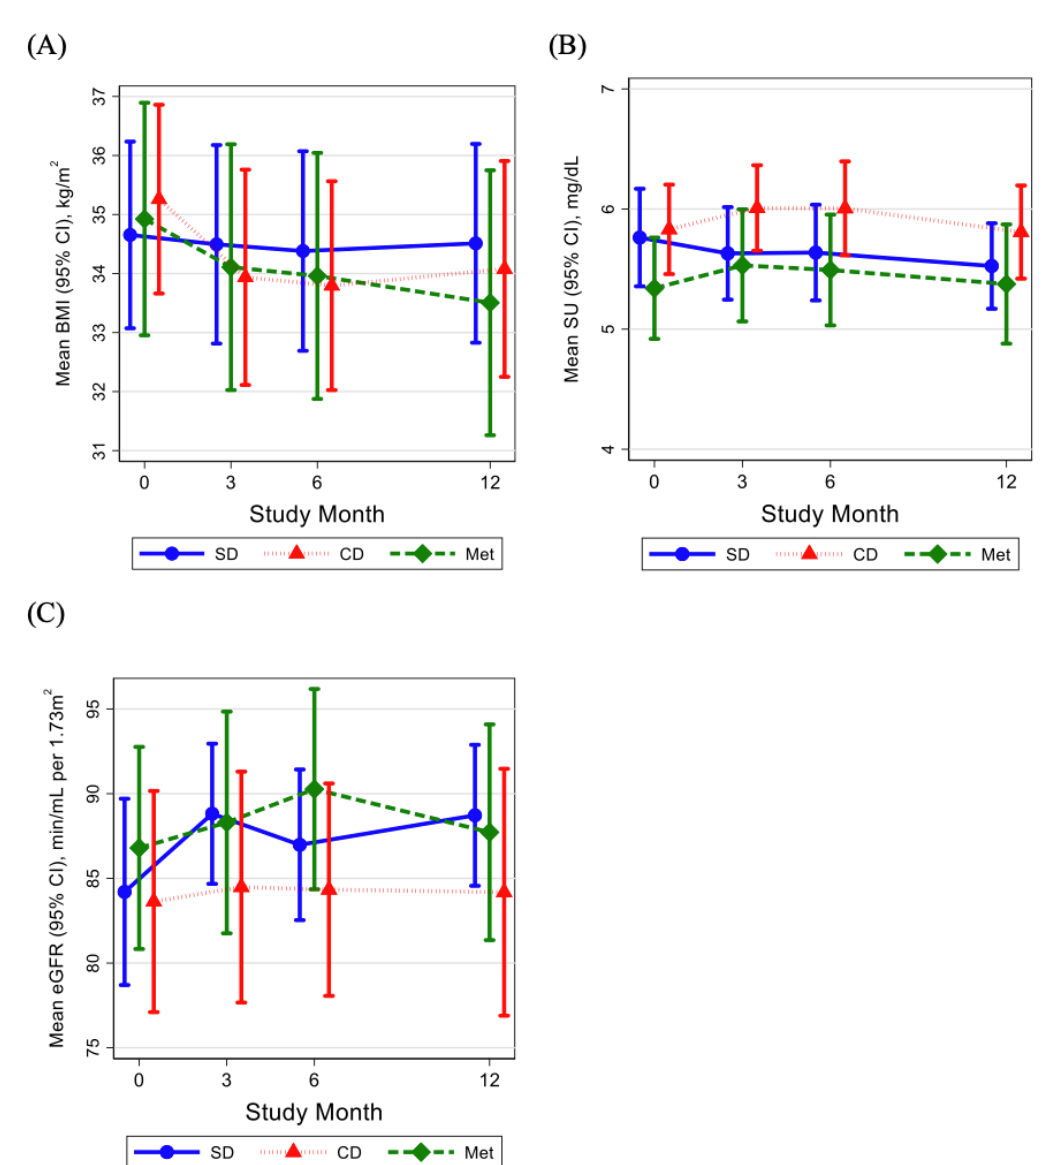
Figure 1. ( A ) Mean body mass index (BMI, in kg/m 2 ) and ( B ) mean serum urate level (SU, in mg/dL) ( C ) mean estimated glomerular filtration rate (eGFR, in mL/min/1.73 m 2 ) of SPIRIT study participants at baseline, 3 months, 6 months, and 12 months, by treatment arm—SD (self-directed weight loss), CD (coach-directed weight loss), or met (metformin). Other abbreviations: CI: confidence interval; eGFR: estimated glomerular filtration rate